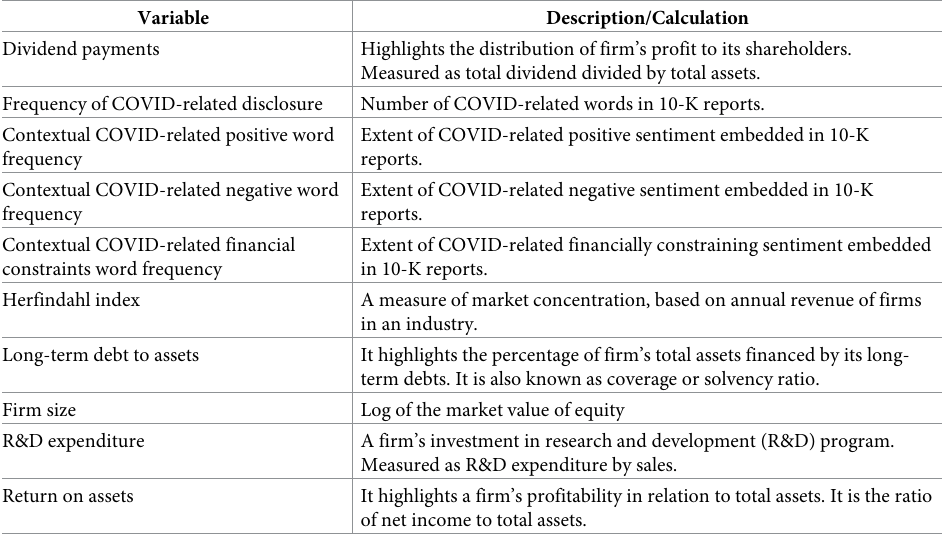
Table 1. Variable